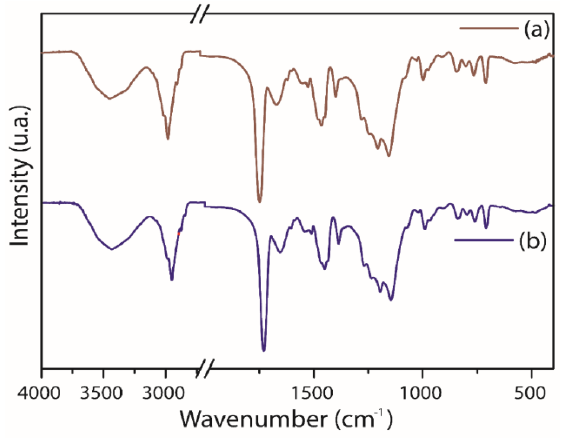
Figure 5. Fourier Transform Infrared (FTIR) spectrum of the Novozym ® 435 before ( a ) and after ( b ) the esterification reaction.